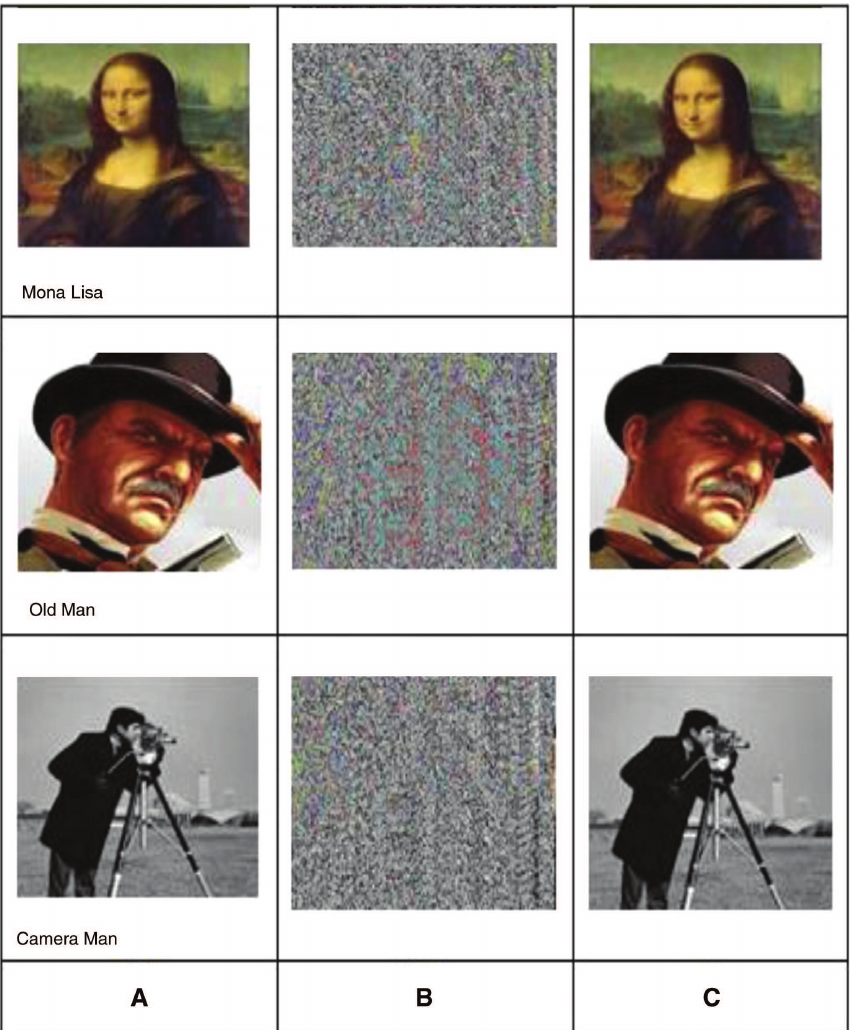
Figure 9: Experimental Result of Encryption and Decryption